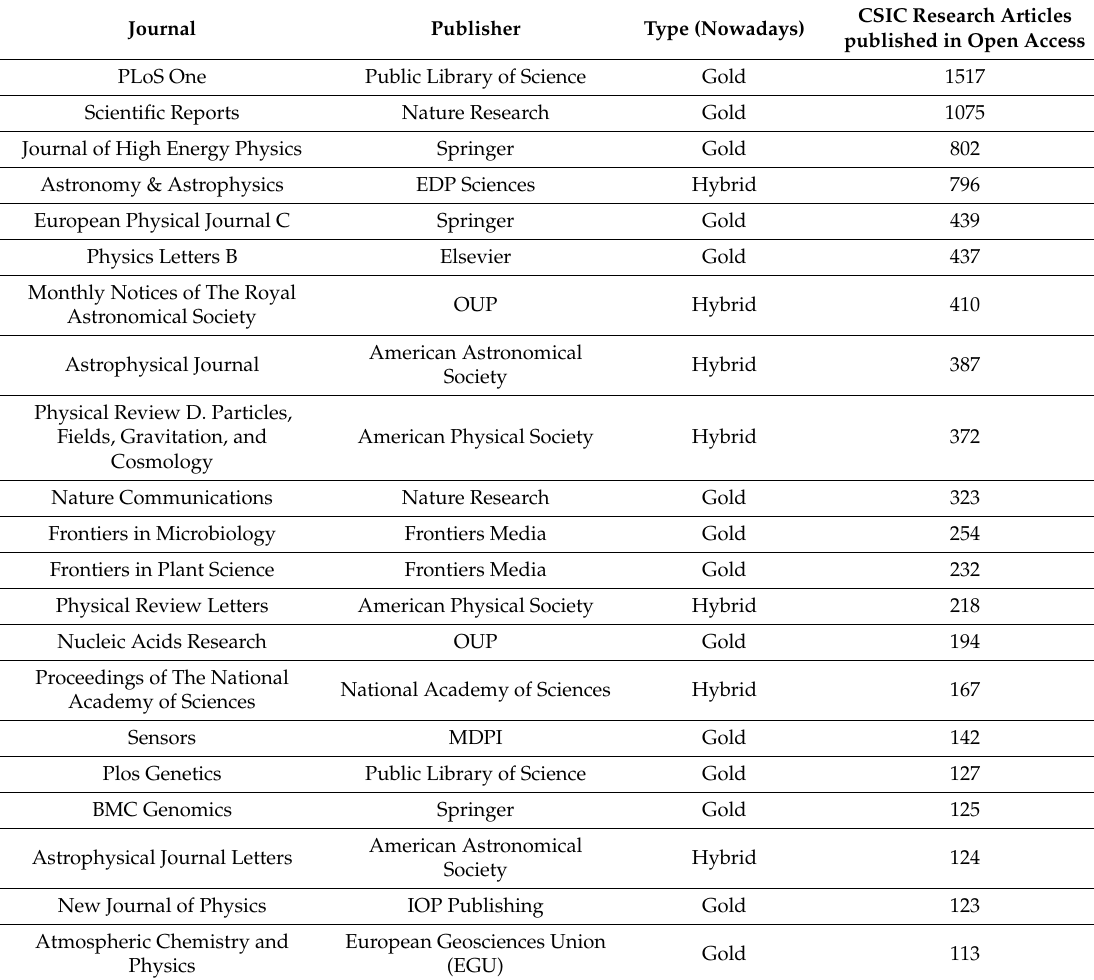
Table 8. TOP20 Journals with CSIC Research Articles in Open Access, 2014–2018 in relation with Open Access Publishing Support